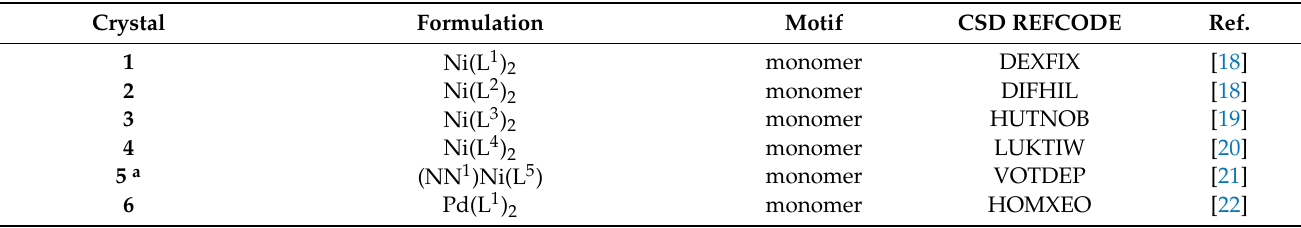
Figure 1. Chemical diagrams for pyridyl-functionalized dithiocarbamate anions L 1 to L 30 . Fc = (C 5 H 4 )Fe(C 5 H 5 ), ferrocenyl. Table 1. Summary of structures 1 – 73 discussed in this bibliographic